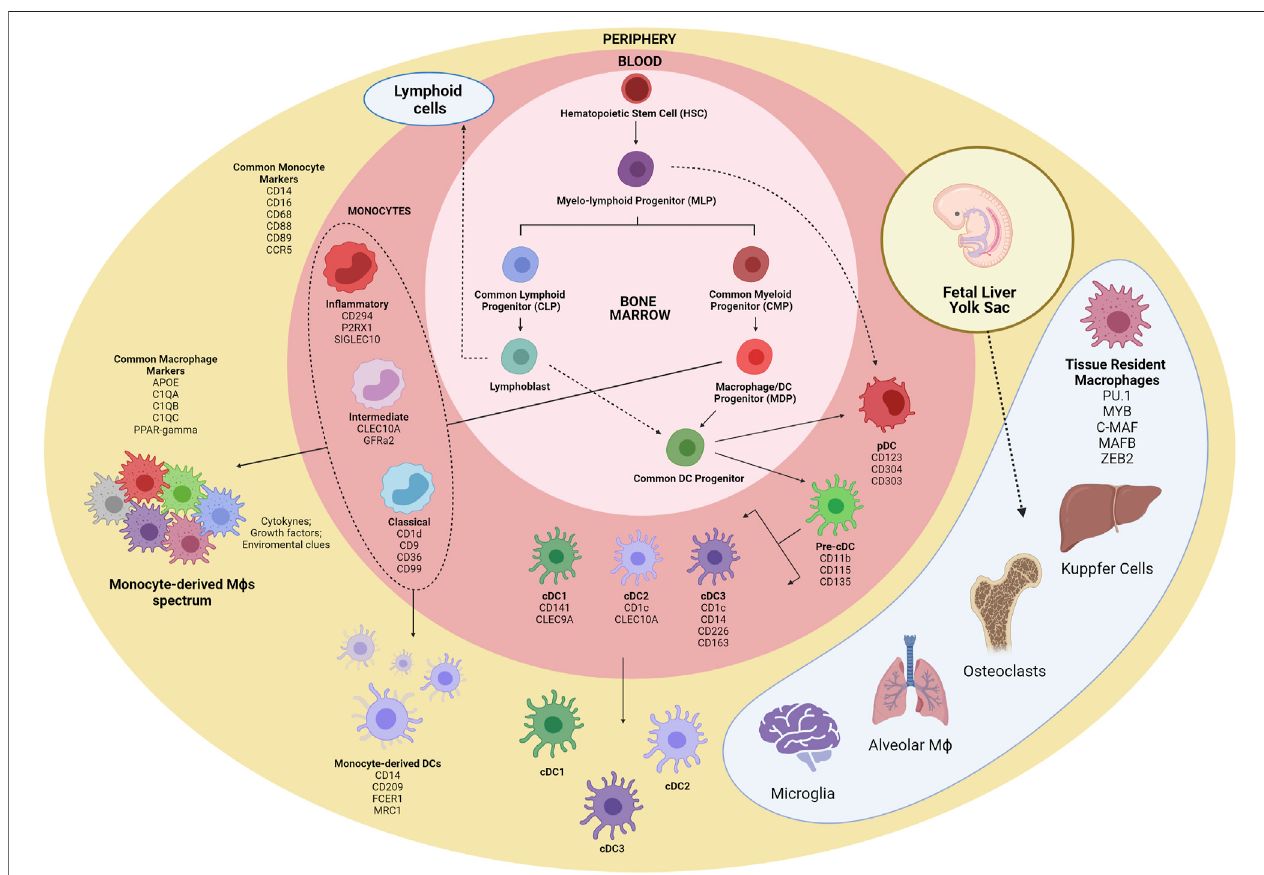
FIGURE1| Schematicoverviewofmyeloidcellsontogeny.The fi rstmyeloidcellsariseintheembryonicphasefromyolksac-derivedprimitiveHSCsandexpandin thefetal liver,originatingGMPsand bloodmonocytes.Tissue-residentmacrophages areestablished beforebirthand aremostlyrepopulatedbyself-renewal. Within the bonemarrow,CMPsgiverisetoGMPsandMDPs.MDPsareresponsibleforthecontributionofmanymacrophagesandDCsubsets.MDPsdifferentiateintomonocytes and CDPs, which in turn differentiate into pDC and pre-cDCs. Following exit from the BM, pre-cDCs enter peripheral organs and mature into cDC1, cDC2, and cDC3. Alternatively, pDCs and cDCs may also originate from MLPs. In fl ammatory cues contribute to monocyte migration to tissues, where they differentiate into macrophages and Mo-DCs. HSC, hematopoeticstem-cell; GMP, granulocyte-monocyte progenitor; CMP, common myeloid progenitor; MDP, macrophage/DC progenitor; MLP, myelo-lymphoid progenitor; CDP, common DC precursor; pre-cDC, precursor of classical DC; Mo-DC, monocyte-derived DC; cDC, classical DC; pDC, plasmacytoid